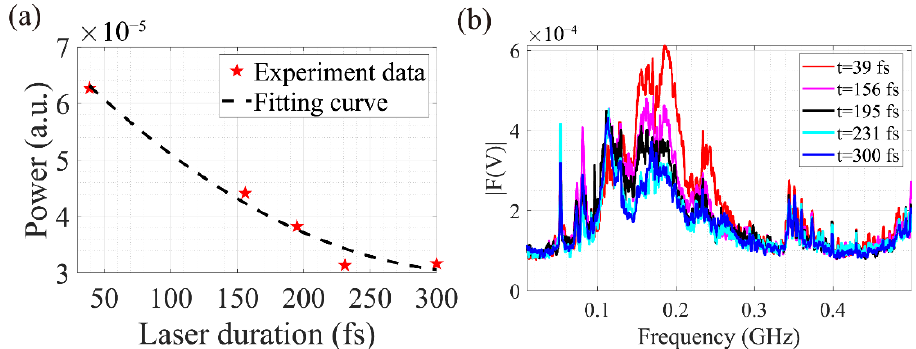
Figure 5. ( a ) The total power of EMPs as a function of t . ( b ) Fourier spectra of the EMP signals for various values of t . The corresponding experimental parameters are: E = 485 mJ, θ = 0°, d = 65 cm, and the different values of t are 39, 156, 195, 231, 300 fs.